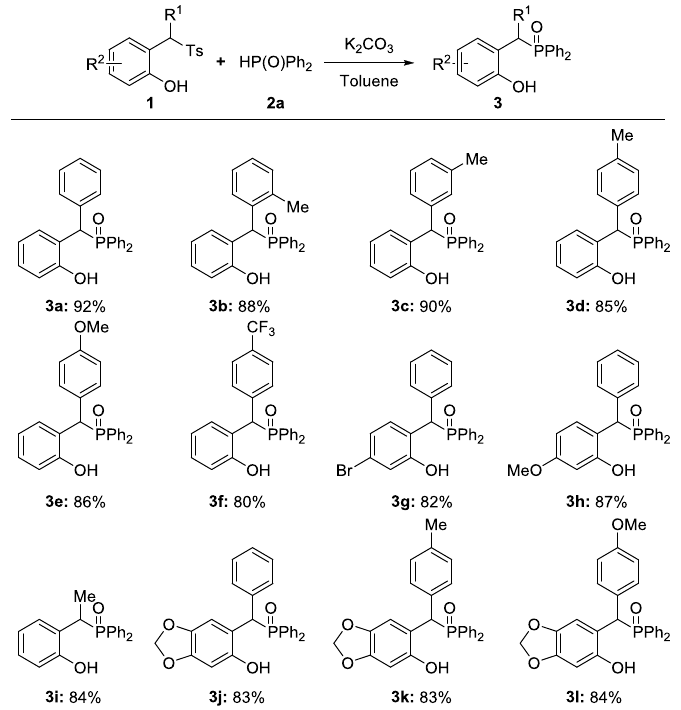
Molecules 2018 , 23 , x FOR PEER REVIEW Table 2. Scope for the reaction of 2-tosylalkyl phenols 1 with diphenylphosphine oxide a .